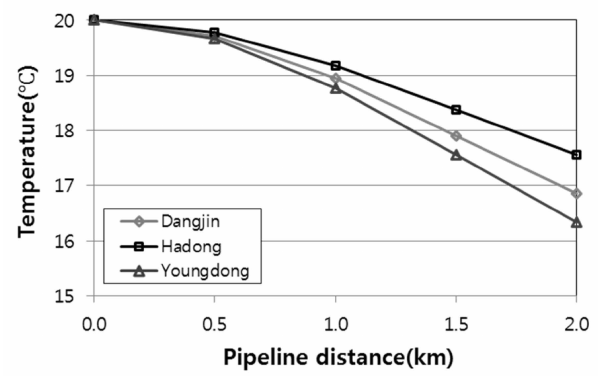
Figure 7. Outlet fluid temperature of each case study area by